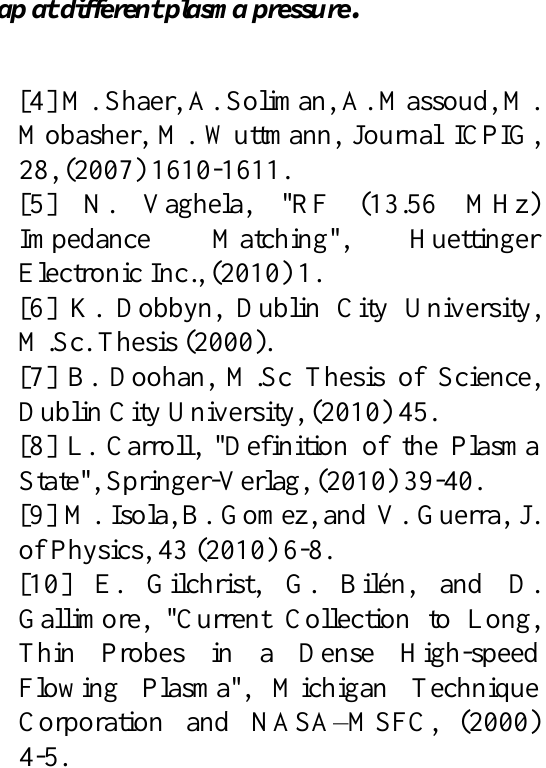
Fig.8: Debye length with electrode gap at different plasma pressure.